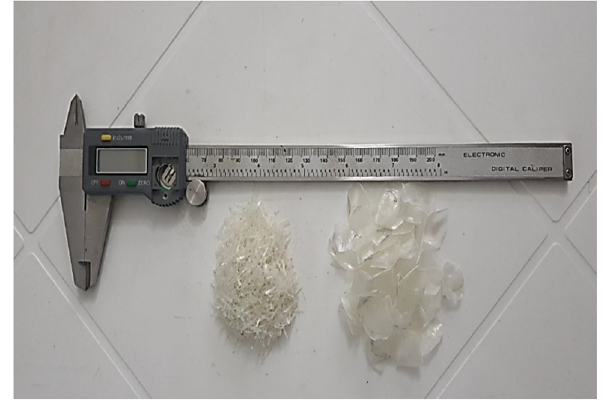
Figure 1: Fish scales and fi sh fl akes.